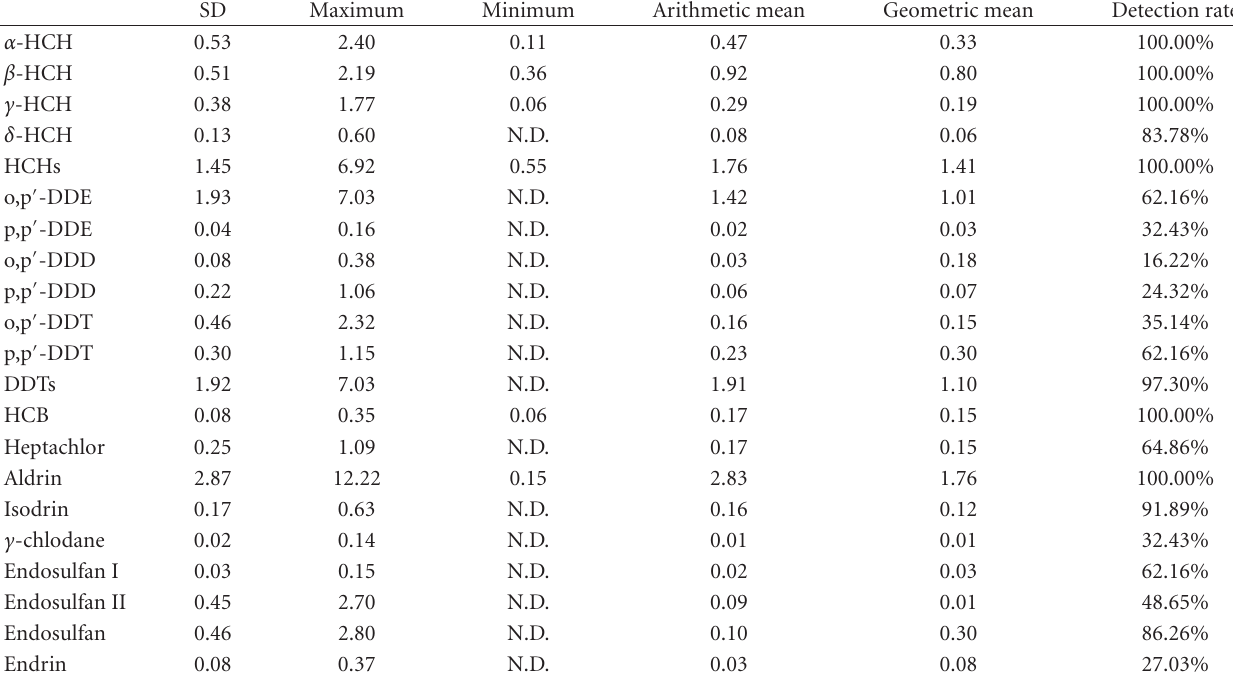
Table 4: The residual levels of OCPs in the water from Lake Chaohu